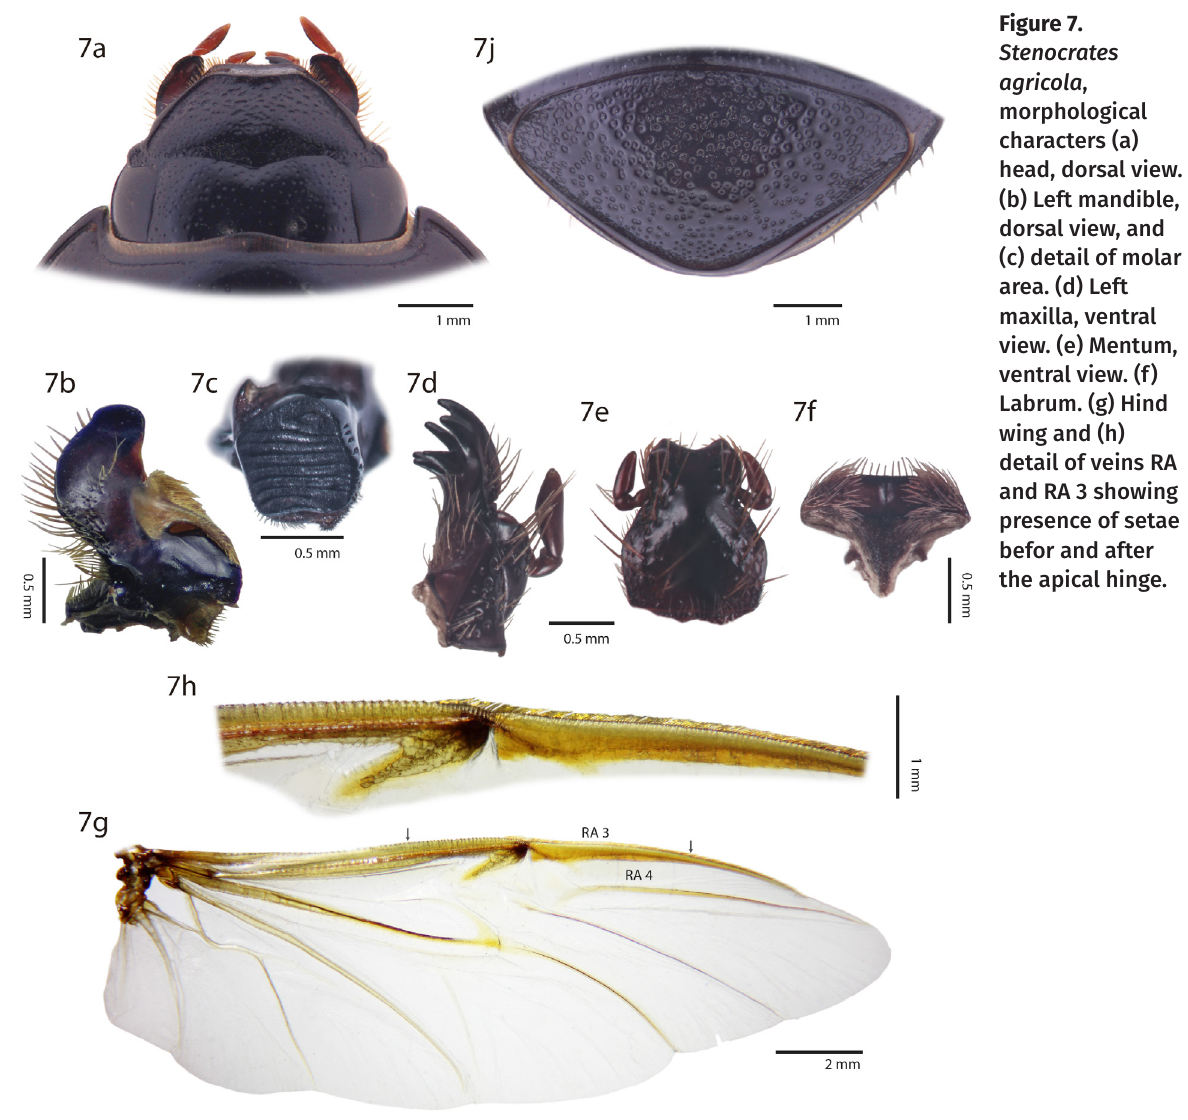
(Figs. 6b–d). First broad interval with simple or double, irregular row of similar punctures, second interval with simple row of punctures only on apical third. Hind wings: Radius vein with single row of pegs, area near apical hinge with row of long, erect setae (Figs. 7g, h), anterior edge distal to apical hinge with erect setae and lacking membranous border. Veins RA 4 and RA 3 separated at their bases. Abdomen. Pygidium: Subtriangular, wider than long (1: 0.5); surface shiny, glabrous,